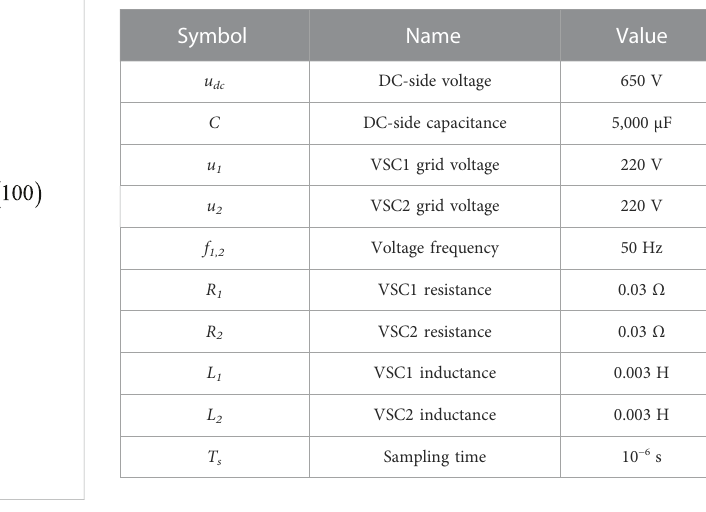
Voltage vector selection in the steady-state αβ coordinate system.